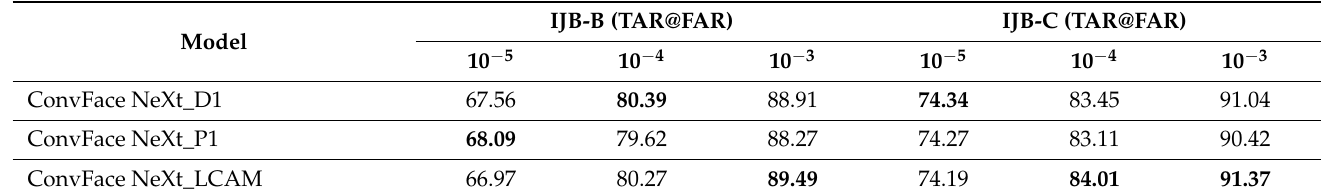
Table 6. Verification accuracy on different integration strategies for IJB-B and IJB-C datasets. (Bold Table 6. Veri fi cation accuracy on di ff erent integration strategies for IJB-B and IJB-C datasets. (Bold values are the highest obtained values by the methods). values are the highest obtained values by the methods.)